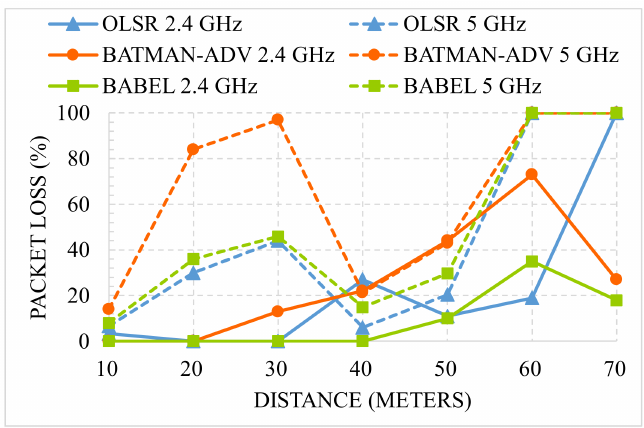
Figure 4. Average packet loss (%) vs. distance (meters) for each protocol and frequency